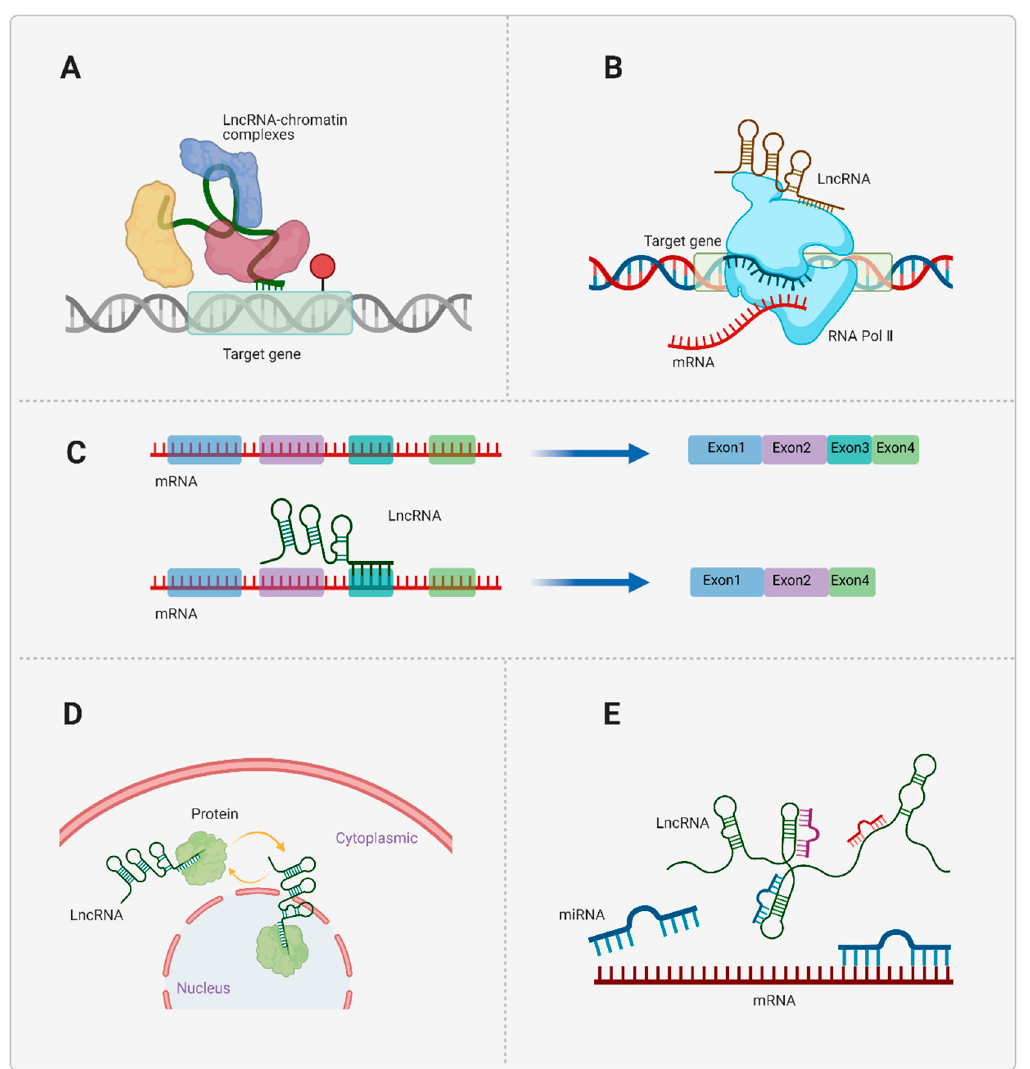
Figure 2. The molecular mechanisms of lncRNAs. ( A ) Participate in epigenetic regulation by recruiting chromatin. ( B ) Regulation of transcription by interfering with recruitment of RNA polymerase II. ( C ) Interfere process of mRNA splicing through binding with complementary sequences. ( D ) Bind to specific proteins and influences their cellular location. ( E ) Serve as a molecular sponge to bind miRNA to form a lncRNA–miRNA axis that in turn modulate mRNA expression. This figure was created with Biorender.com (accessed on 4 October 2022).